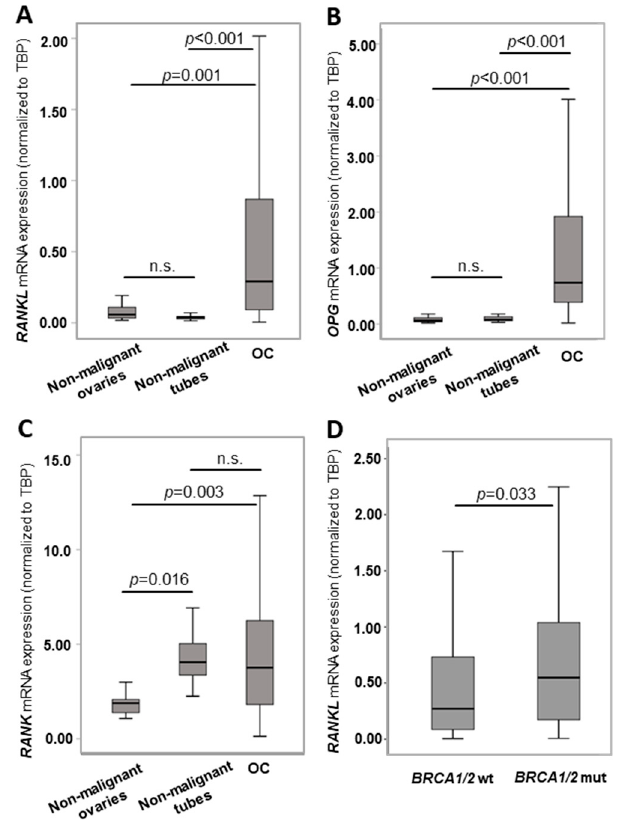
Figure 1. RANK, RANKL and OPG mRNA expressions are elevated in OC tissue, particularly in BRCA1/2 mutated OC. ( A ) RANKL , ( B ) OPG and ( C ) RANK expression in non-malignant ovaries ( n = 21), non-malignant fallopian tubes ( n = 14) and OC ( n = 192). ( D ) RANKL mRNA expression in BRCA1/2 mutated (mut) OC ( n = 44) compared to BRCA1/2 wild-type (wt) tumours ( n = 146). RANK , RANKL and OPG mRNA expression values were normalized to TBP expression, n.s., not significant.